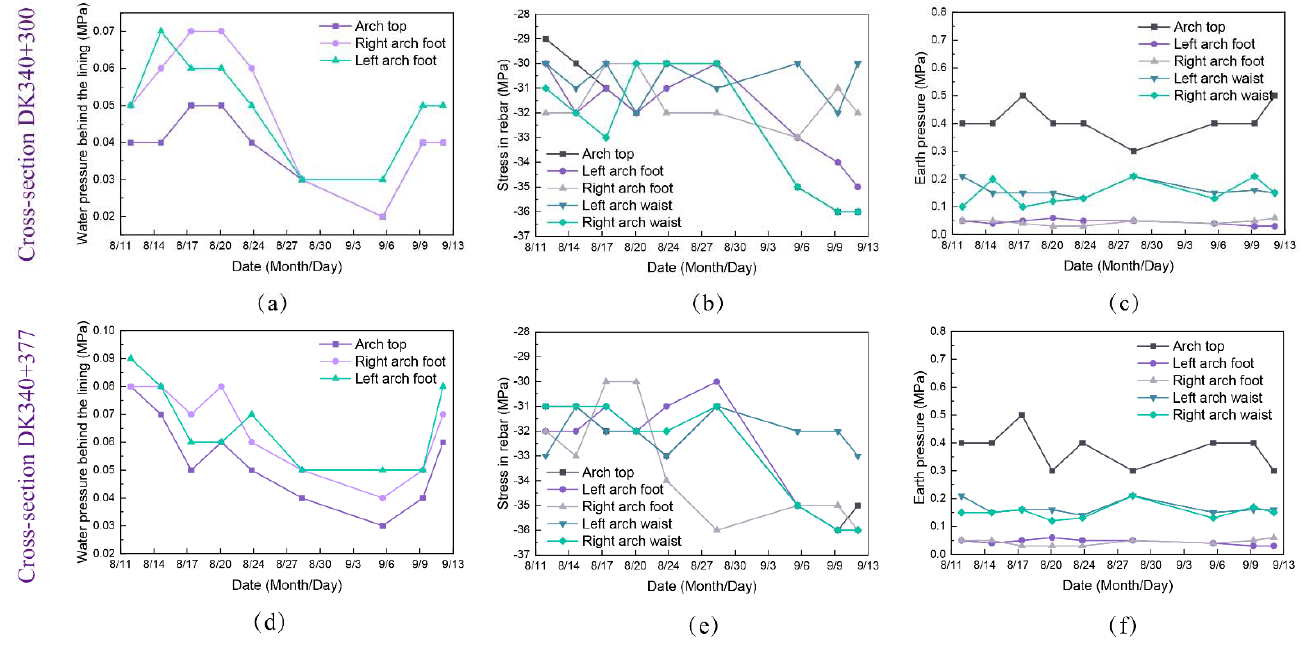
Figure 22. Results of field measurements at monitoring sections: ( a ) results of water pressure monitoring at section DK340+300; ( b ) results of rebar stress monitoring at section DK340+300; ( c ) results of earth pressure monitoring at section DK340+300; ( d ) results of water pressure monitoring at section DK340+377; ( e ) results of rebar stress monitoring at section DK340+377; ( f ) results of earth pressure monitoring at section DK340+377.